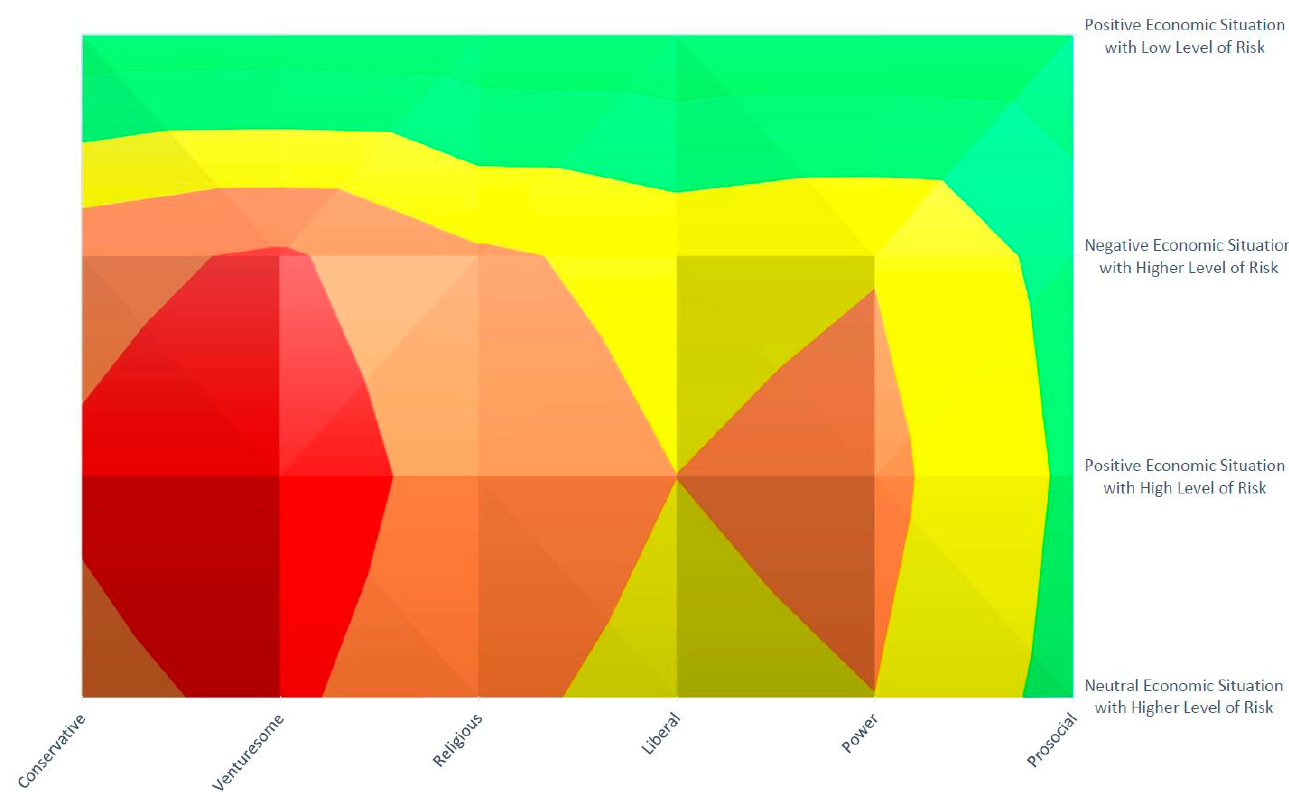
Chart 3. Surface projection of anticipated personal risk levels for financial risk groups value types and economic